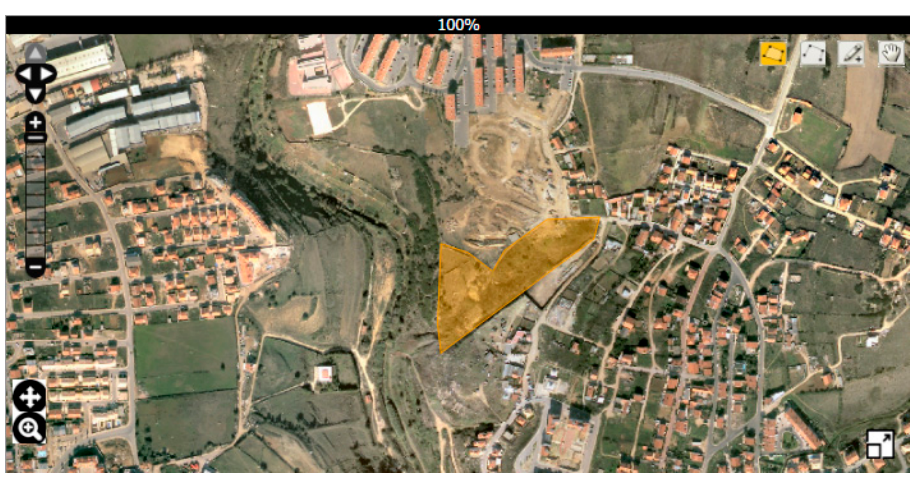
Figure 7. Polygon used in first and second scenario.